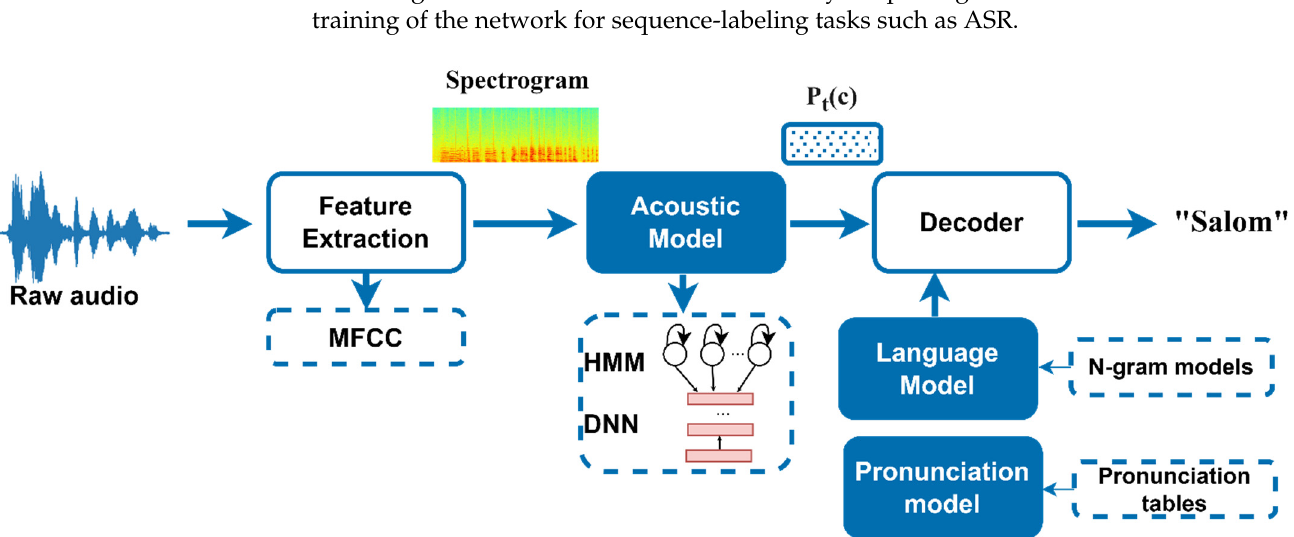
Figure 2. Overview of the proposed Uzbek language ASR system.